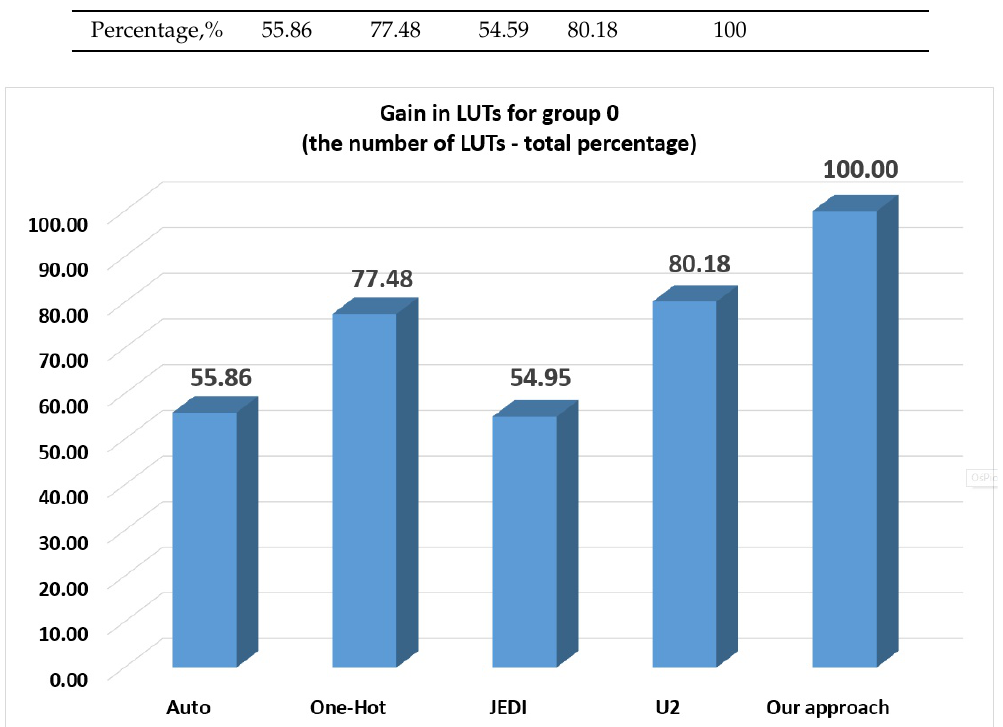
Figure 11. Gain in LUTs for group 0 (LUT count—total